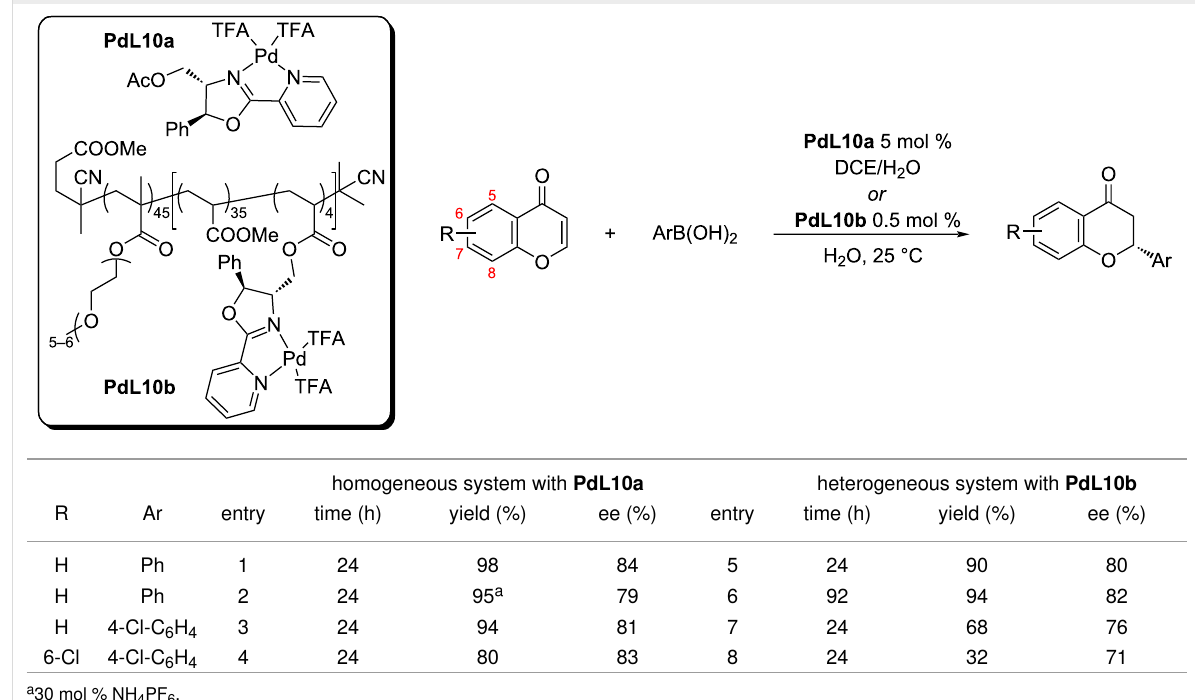
Table 28: Micellar nanoreactor for the synthesis of substituted flavanones [56].